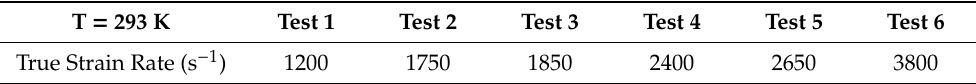
Table 9. SHPB test conditions at room temperature (293 K).